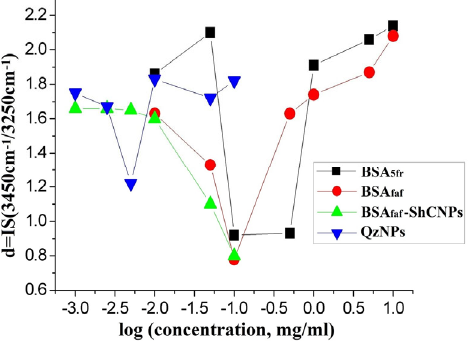
Figure 2. Changes in the ratio of the parameter d= IS(3450 cm − 1 )/IS(3250 cm − 1 ) of the Raman spectra in the range of 3000–3650 cm − 1 on the concentration of dispersion components (as a logarithm of the concentration, in mg/mL). Bovine serum albumin (BSA) protein in various ligand states, top to bottom: BSA 5fr ; BSA faf ; ShC NPs; andQz NPs. The relative error in determining the ratio did not exceed 10%.